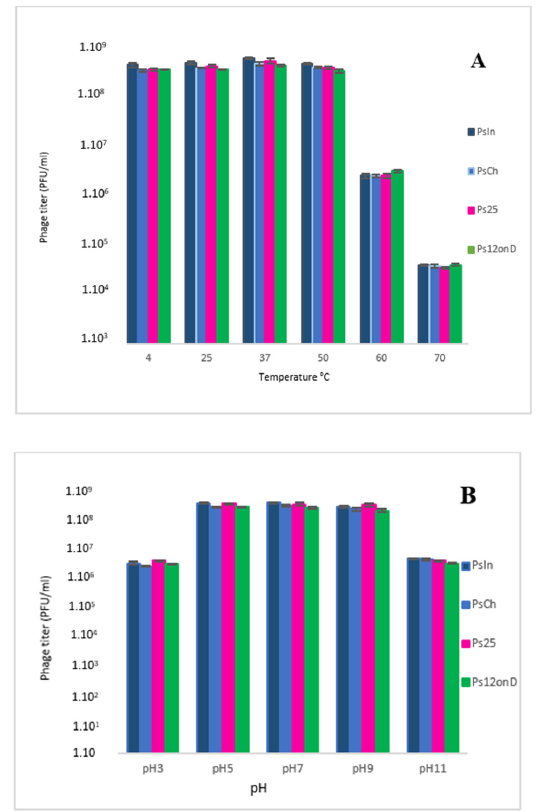
Figure 4. Thermal and pH stability. ( A ) Activity of phages PsIn, PsCh, Ps12on-D, and Ps25 at different pH levels. ( B ) Activity of phages PsIn, PsCh, Ps12on-D, and Ps25 at different temperatures. Each experiment was performed in triplicate and standard deviations are indicated.